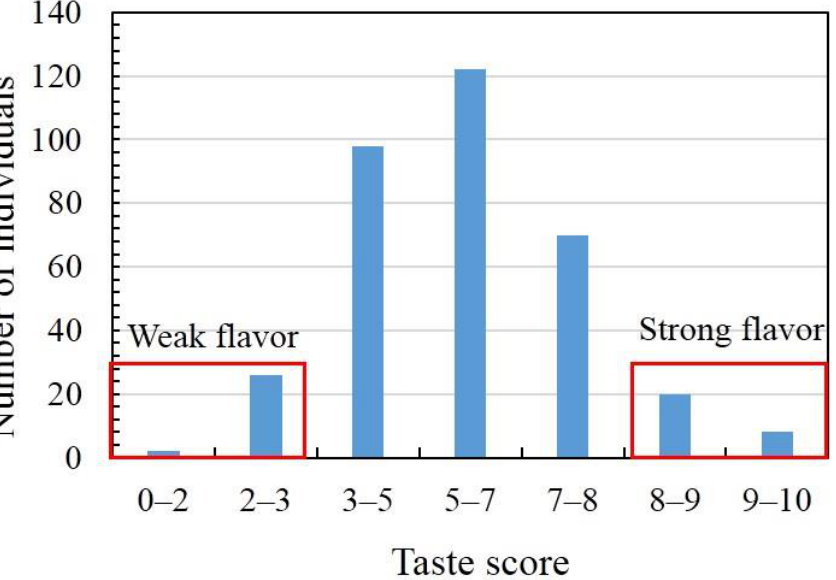
Figure 6. Frequency distribution of taste scores for 346 MAGIC population elite lines of marketable bottle gourd fruit. The DNA of 28 elite lines with extreme phenotypes (high and low taste scores) was selected to prepare strong- and weak-flavor bulks.